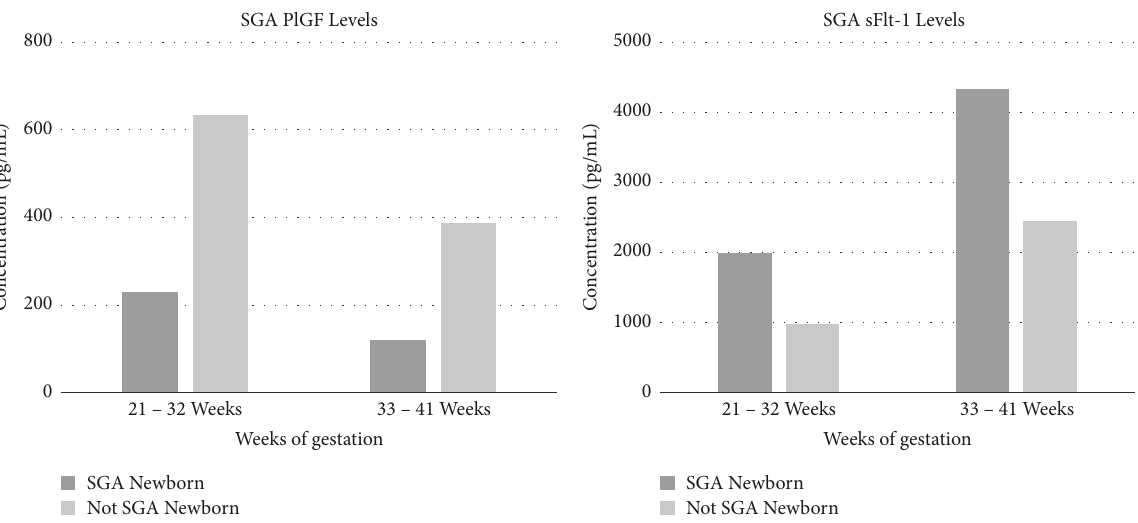
Figure 6: PlGF and sFlt-1 results obtained during different gestational periods in women with PE who later delivered small for gestational age (SGA) newborns and those that delivered infants of normal gestational size [53].